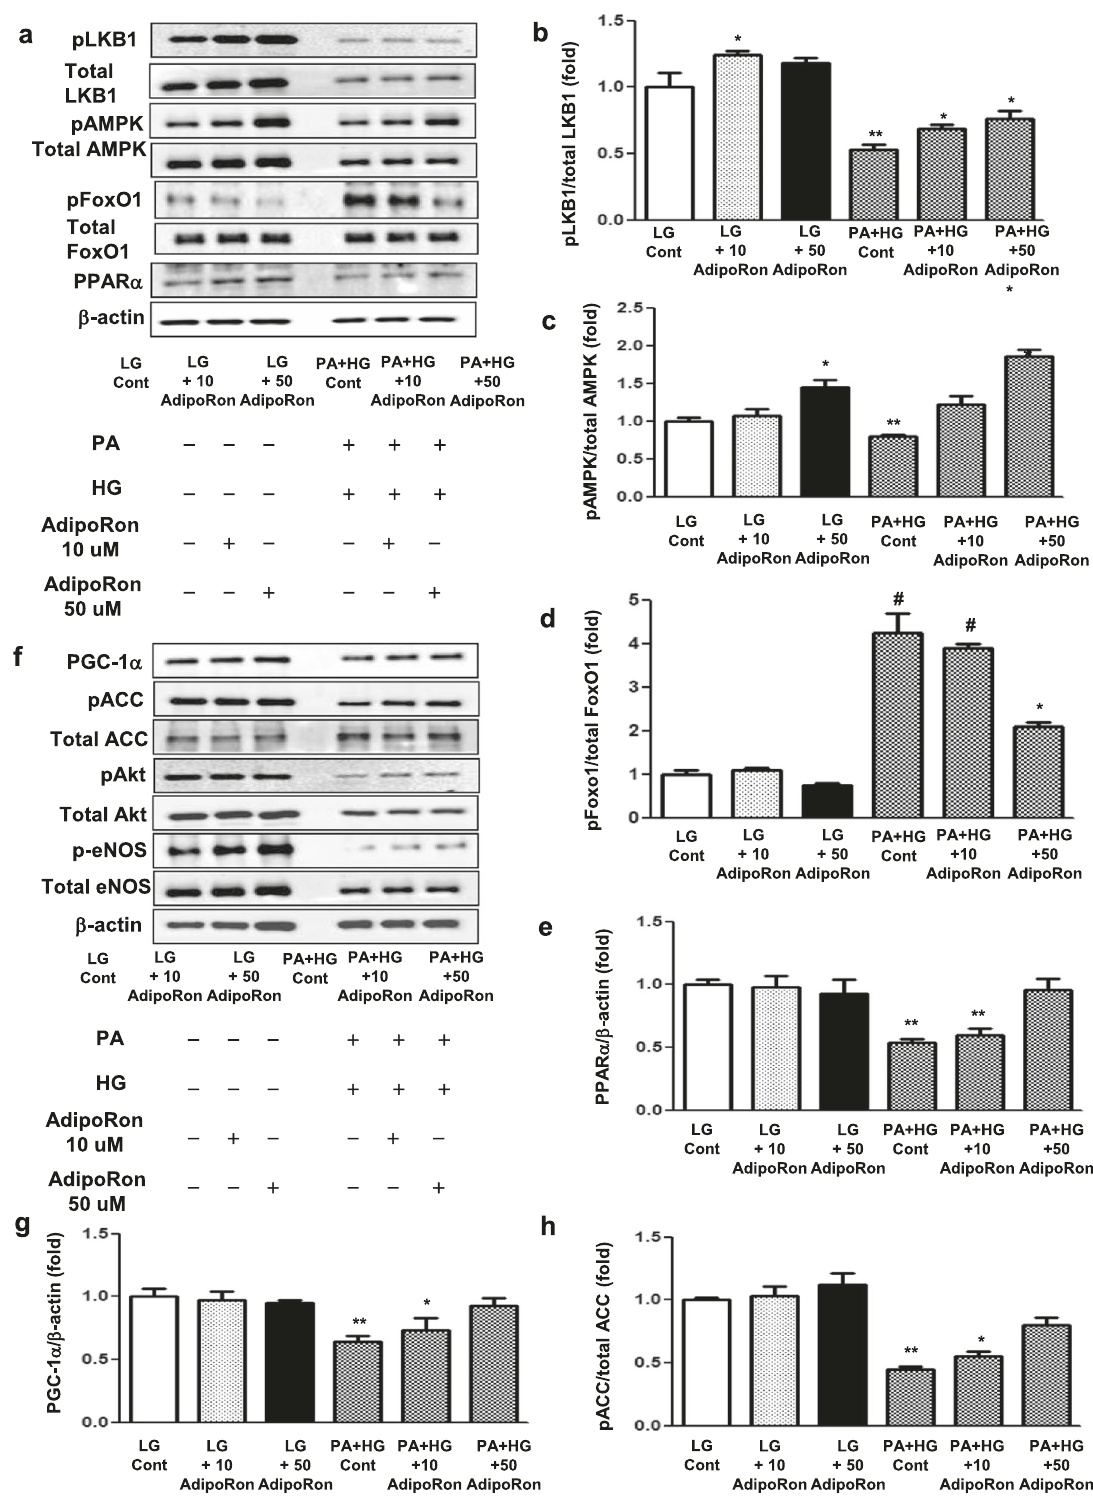
Fig. 5 Effect of AdipoRon on downstream signaling pathways in human cardiomyocytes cultured in low- or high-glucose (LG, HG) and palmitate (PA) media with or without AdipoRon. a Representative images of western blotting of pLKB1, total LKB1, pAMPK, total AMPK, pFoxO1, total FoxO1, PPAR α , and β -actin levels . b – e Quantitative analyses according to groups. f Representative images of western blotting of PGC-1 α , phosphorylated ACC, total ACC, pAkt, total Akt, phosphorylated Ser 1177 eNOS, total eNOS, and β -actin levels. g – j Quantitative analyses according to groups. k Representative images of immuno fl uorescence staining of DHE expression and TUNEL-positive cells. l , m Quantitative analyses according to groups. * P < 0.05, ** P < 0.01, and # P < 0.001 compared with other groups. Scale bars, 20 μ m (in k).